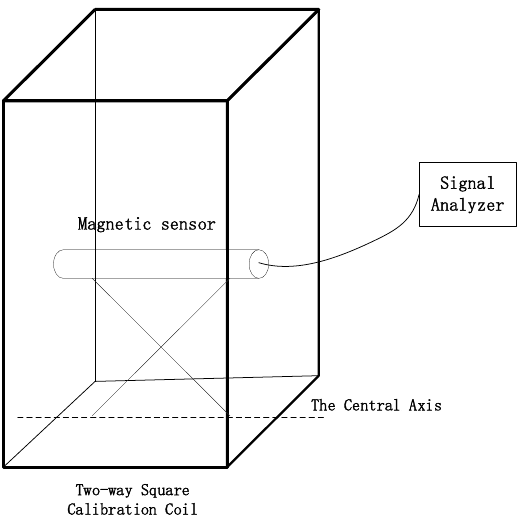
Figure 7. Amplitude-frequency characteristic test block diagram.